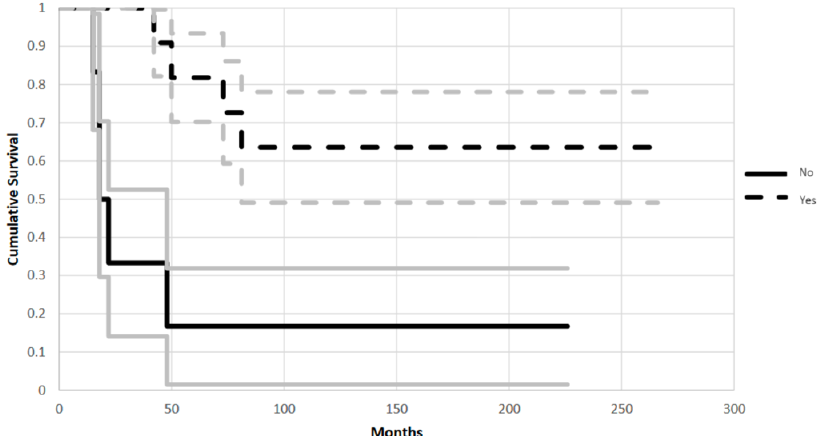
Figure 5. Kaplan-Meier plot shows improved mechanical survival in Group 2 (Yes) using artificial ligament, at 120 months (CI 95%, p = 0.02). The endpoint of analysis was at least one surgical operation for revision of implant due to mechanical failure (aseptic loosening, fracture or resorption of the allograft, dislocation or breakage of the hardware). Grey lines represent standard deviation.